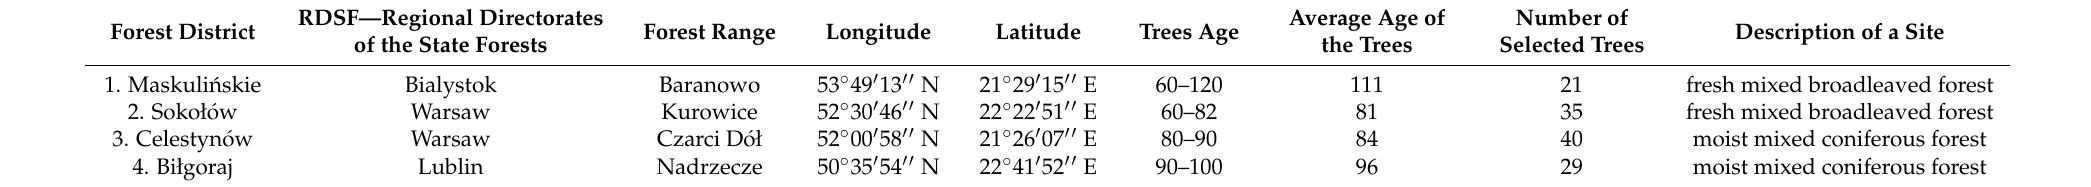
Table 1. Basic data of research